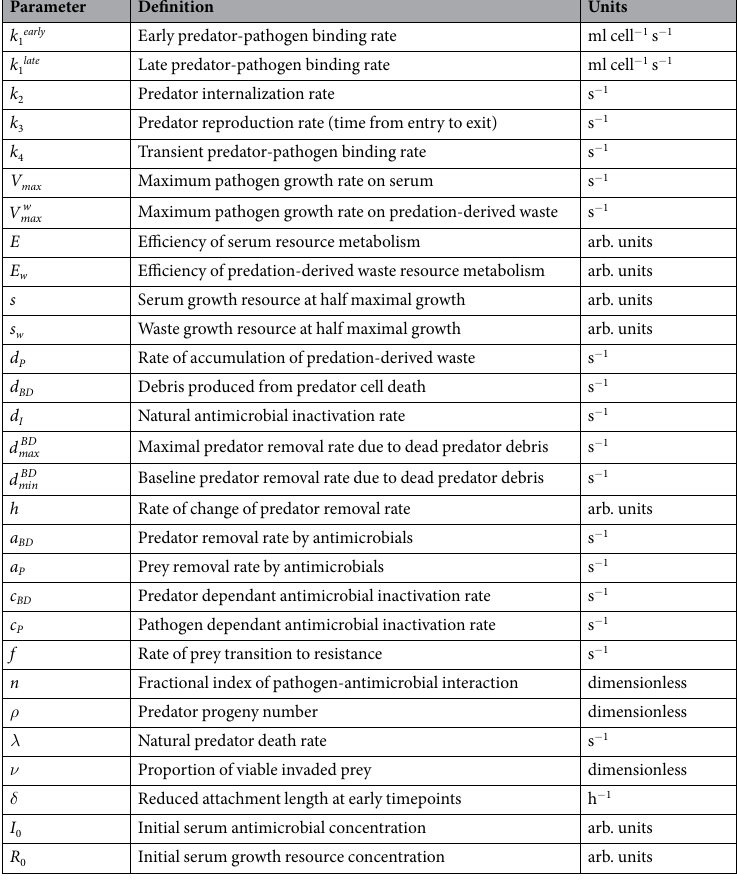
Table 2. Parameters used in both buffer and serum models with definitions and